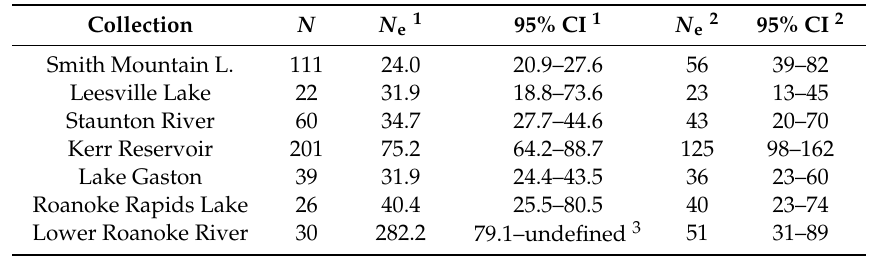
Table 8. Estimated e ff ective breeding number for upper Roanoke River populations of striped bass, with 95% confidence intervals